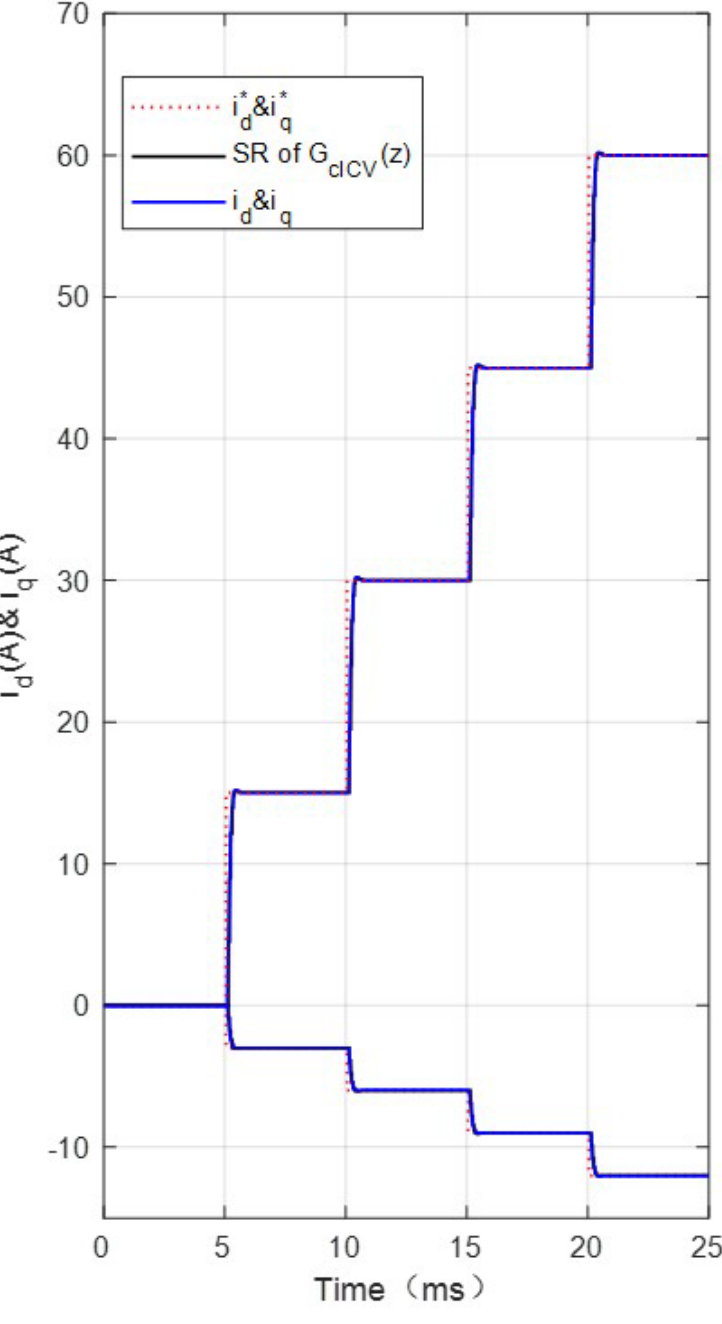
Figure 9. Simulation result of complex vector controller based on flux-linkage data ( k = 0.3) of the locked saturated machine.